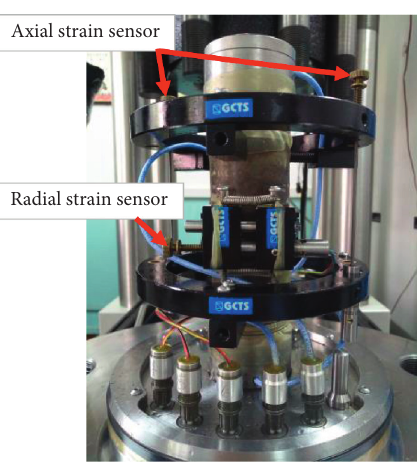
Figure 3: Deformation measuring device.